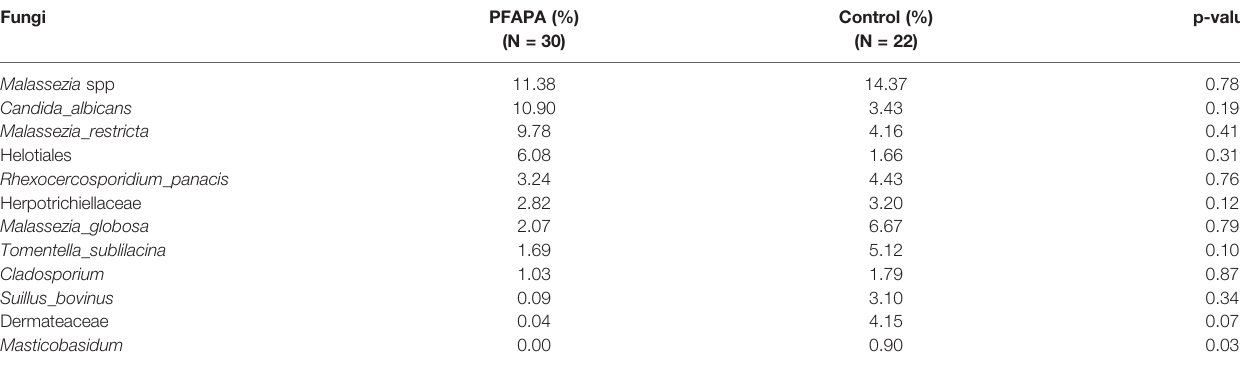
TABLE 2 | The mean relative abundances of most abundant fungal species in pharyngitis and adenitis syndrome (PFAPA) children and